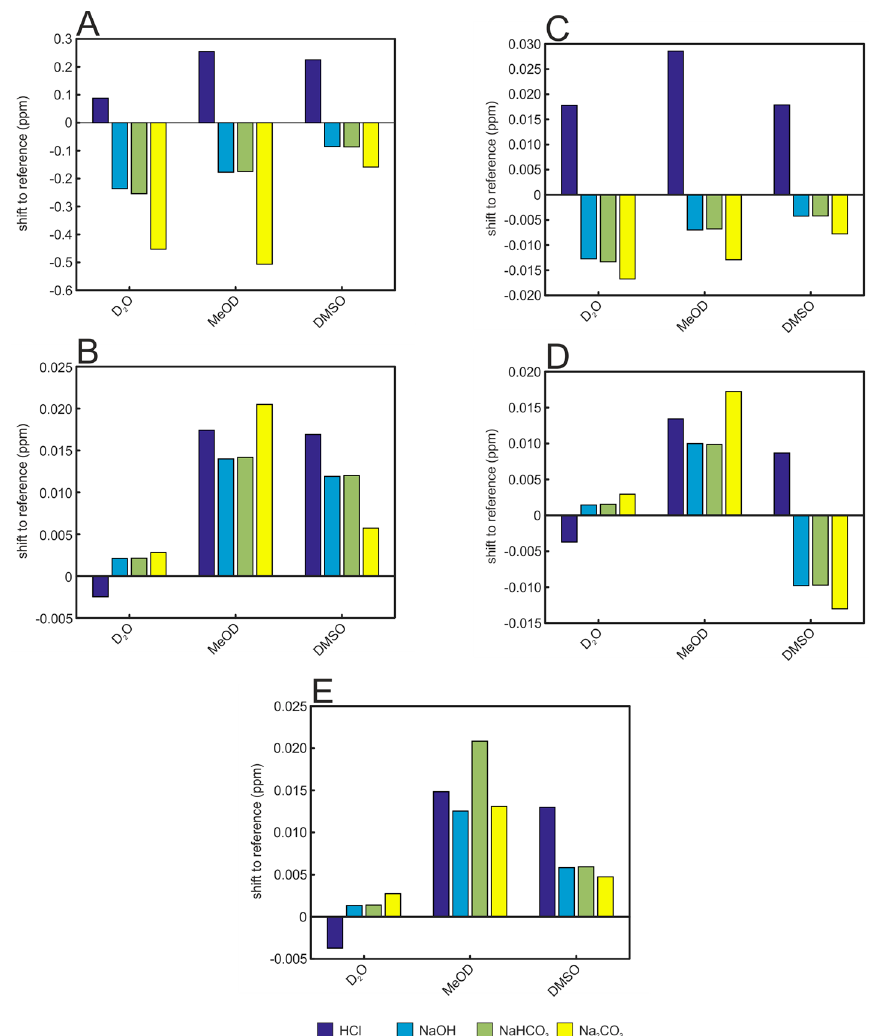
Figure 4. Effect of various acid, base, and salt solutions on the signal positions of selected metabolites in urine samples. Shifts are shown relative to the samples without any acid/base/salt solution added.